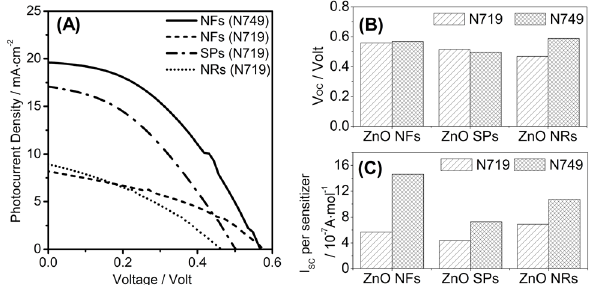
Figure 8: (A) Current-voltage characteristic ( I - V ) of DSSCs using ZnO SPs-, ZnO NFs-, and ZnO NRs-photoanode annealed at 300 o C. (B) Average open circuit voltage V and (C) light harvesting OC performance indicated by photocurrent conversion per mol adsorbed on ZnO